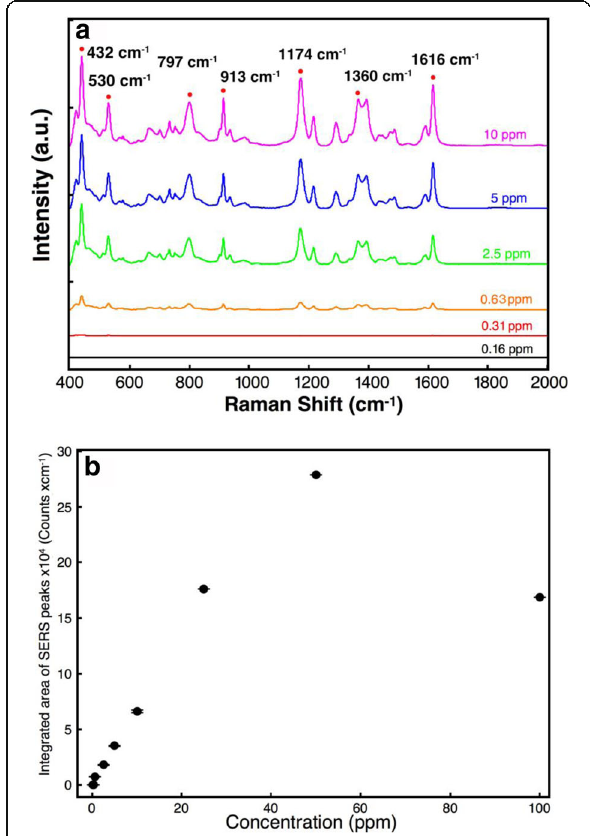
Fig. 6 a SERS spectra of malachite green at different concentrations (from 0.16 to 100 ppm). b Integrated area of 1174 cm − 1 peak of adenine